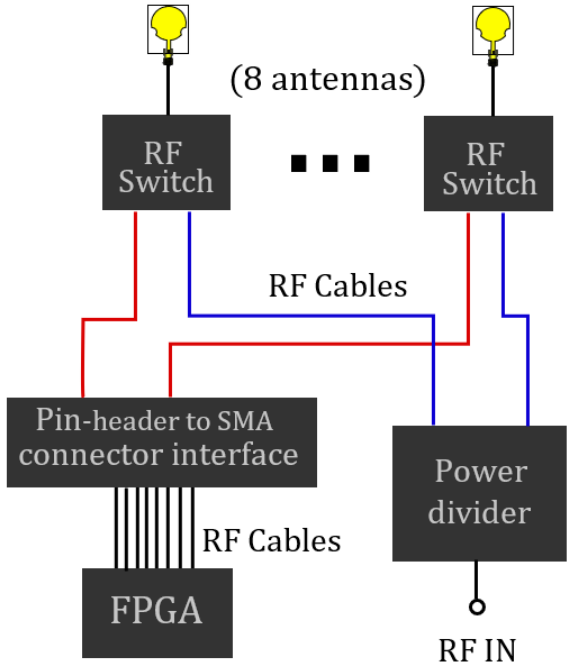
Figure 5. Block diagram of time-modulated arrays.